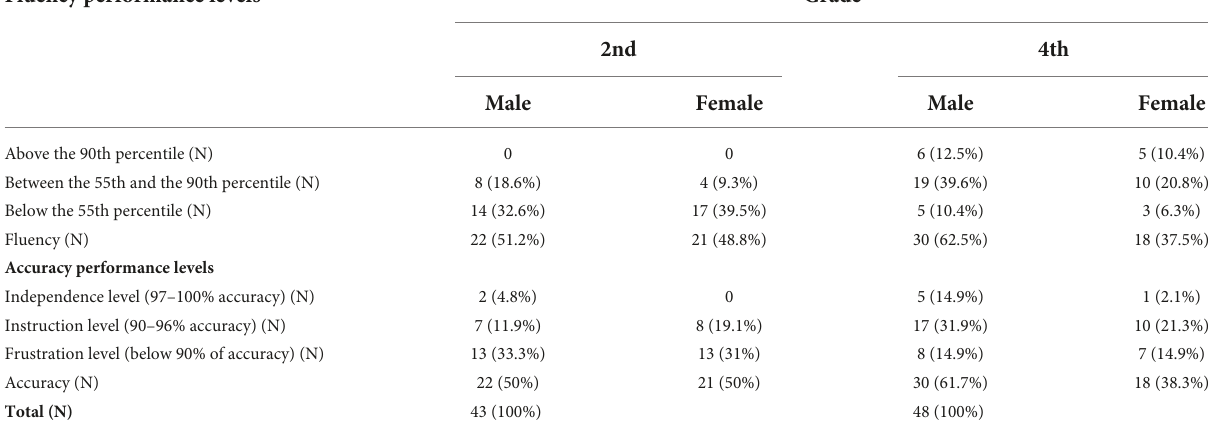
TABLE 4 Fluency and accuracy performance levels per grade and gender, before the intervention. Fluency performance